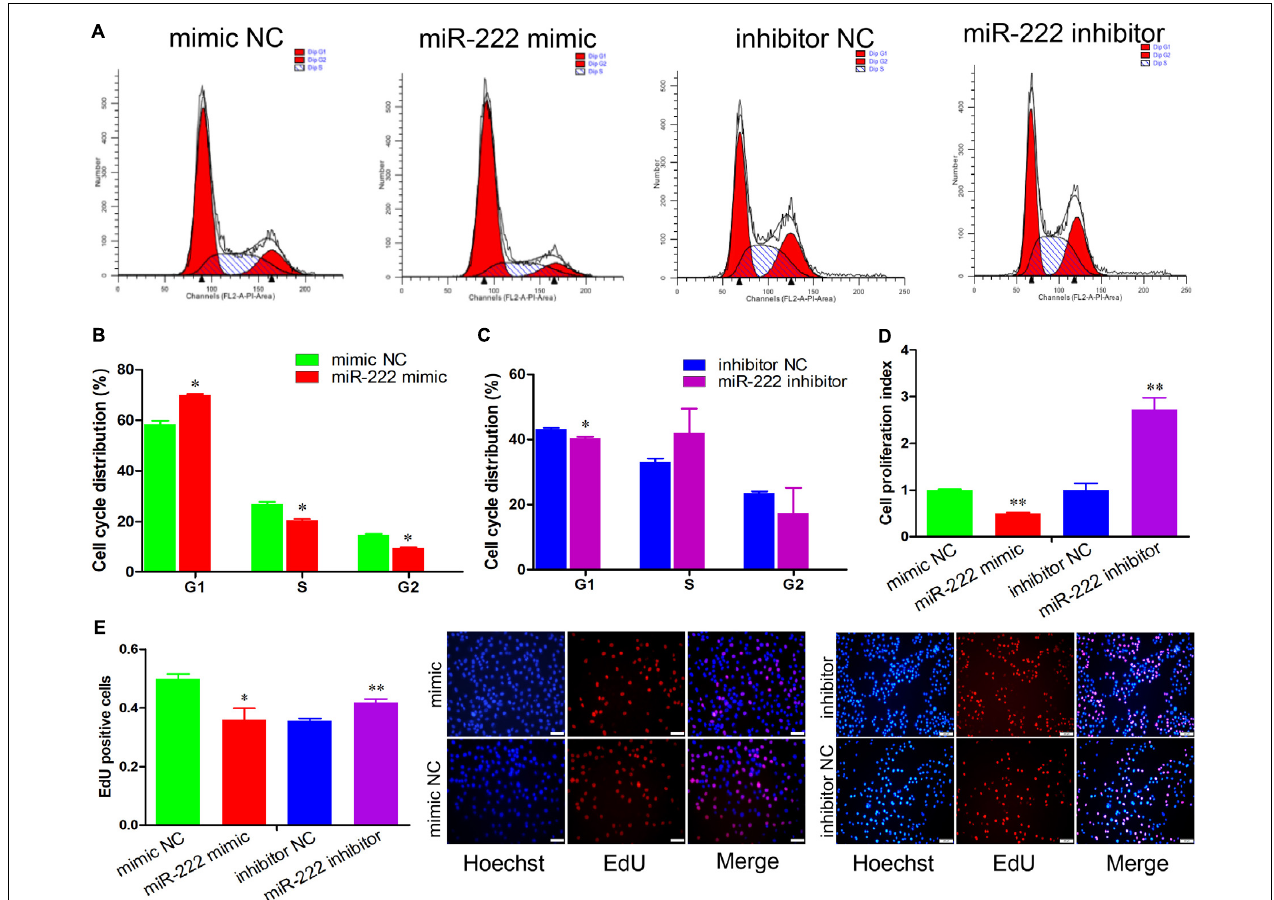
FIGURE 1 | miR-222 represses immature porcine Sertoli cell proliferation. (A) The immature porcine Sertoli cells were transfected with mimic NC, miR-222 mimic, inhibitor NC, or miR-222 inhibitor ( n = 3). The cell cycle was analyzed using a FACSCanto II flow cytometer. (B,C) The cell cycle distribution was calculated using the miR-222 mimic (B) or miR-222 inhibitor (C) transfected cell group ( n = 3). (D) The CCK-8 kit was used to measure the effect of miR-222 on cell proliferation ( n = 3). The absorbance value of each well was detected using an ELISA plate reader at 450 nm. (E) The cell mitotic activity was detected using the EdU corporation assay ( n = 3). Representative images of EdU staining of immature porcine Sertoli cells 24 h after transfection. Scale bar = 200 µ m. Data are presented as mean ± SD. ∗ P < 0.05 and ∗∗ P <